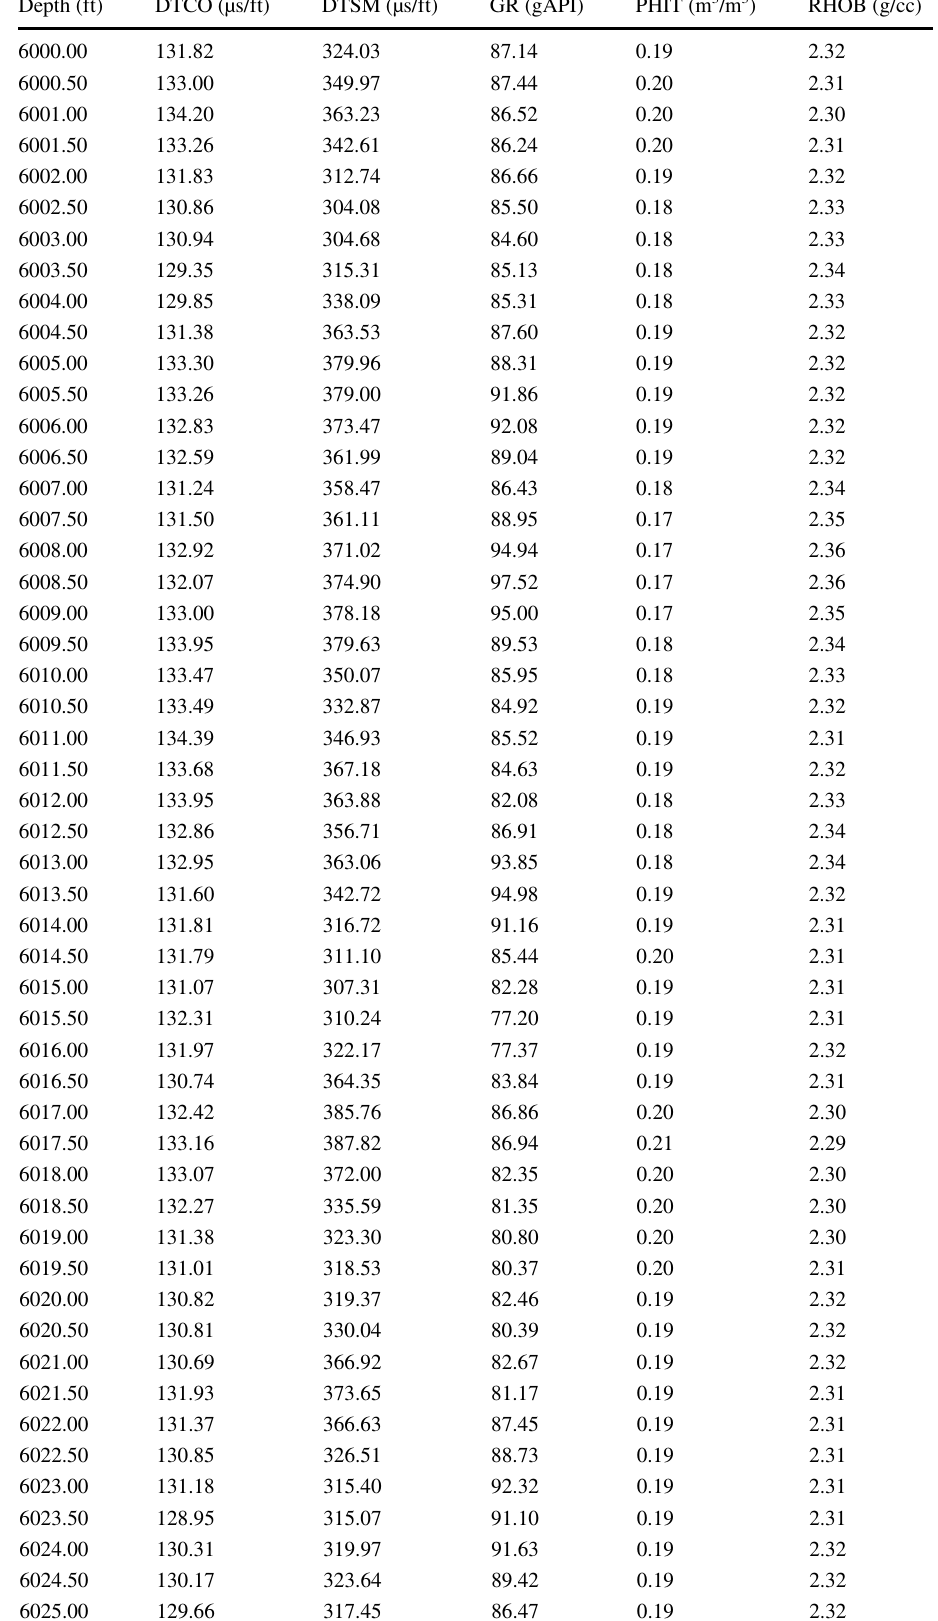
Table 5 50 ft of available well log data for the